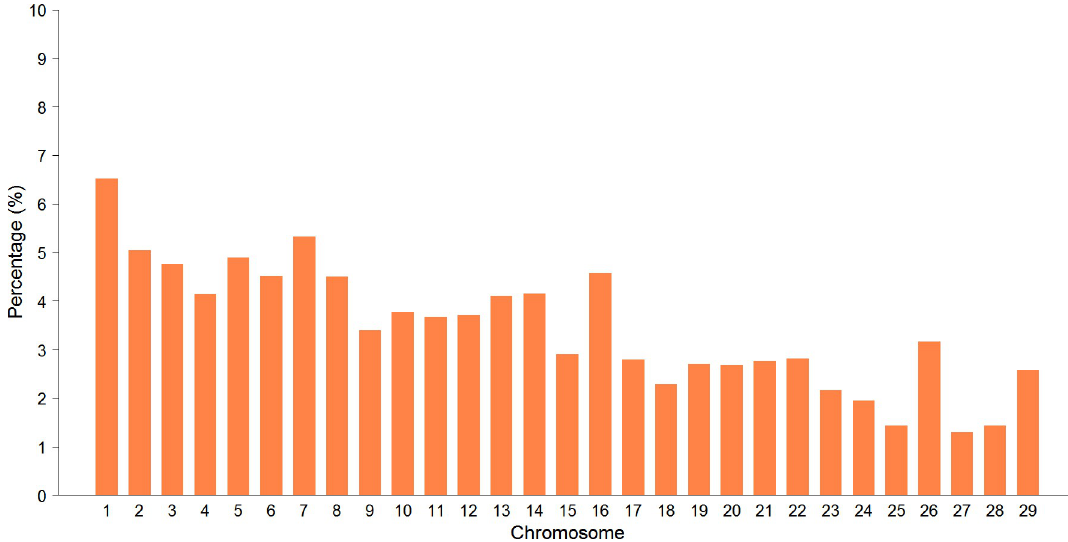
Fig 1. ROH percentage by chromosome in the Mexican Holstein